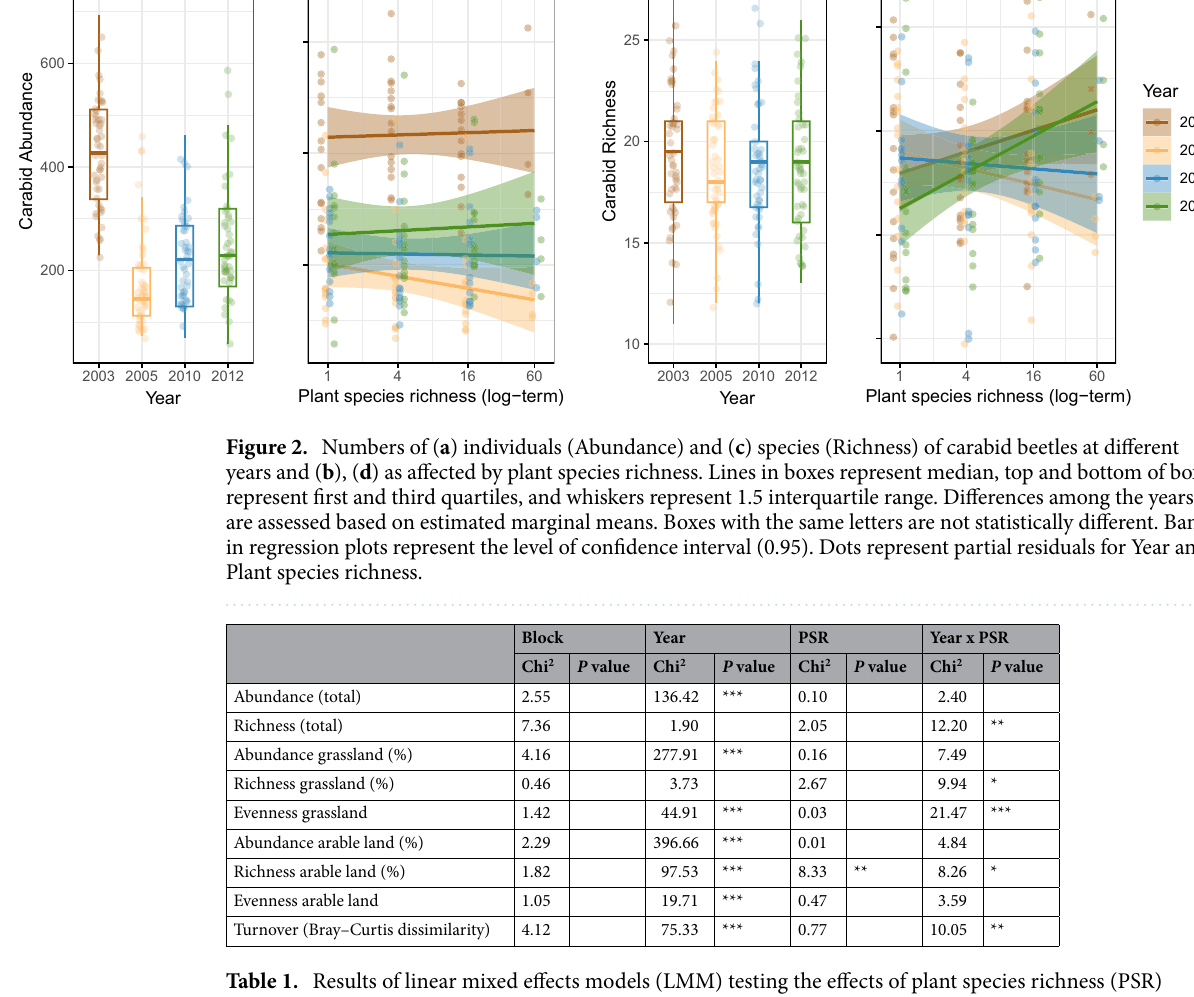
Table 1. Results of linear mixed effects models (LMM) testing the effects of plant species richness (PSR) and its changing effect over time on carabid abundance, richness, the proportion (%) of arable and grassland individuals and species and on the turnover of the community assemblage. Asterisks mark the level of significance (‘***’ < 0.001, ‘**’ < 0.01, ‘*’ < 0.05, ‘.’ < 0.1). Please note, for assessing the turnover, Period was fitted instead of Year, see